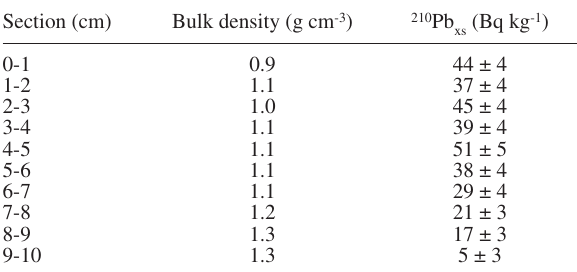
Table 2. – Bulk density and 210 Pb profiles in sediment core BC4 xs from the outer Bay of Cádiz. Section